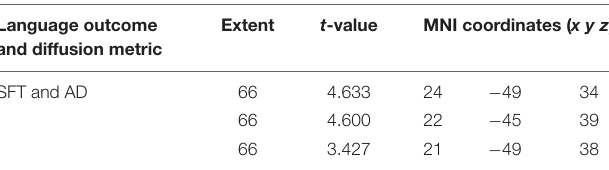
TABLE 3 | Locations of regions showing significant negative relationships between AD and performance on the SFT as shown in Figure 3 . Language outcome and diffusion metric